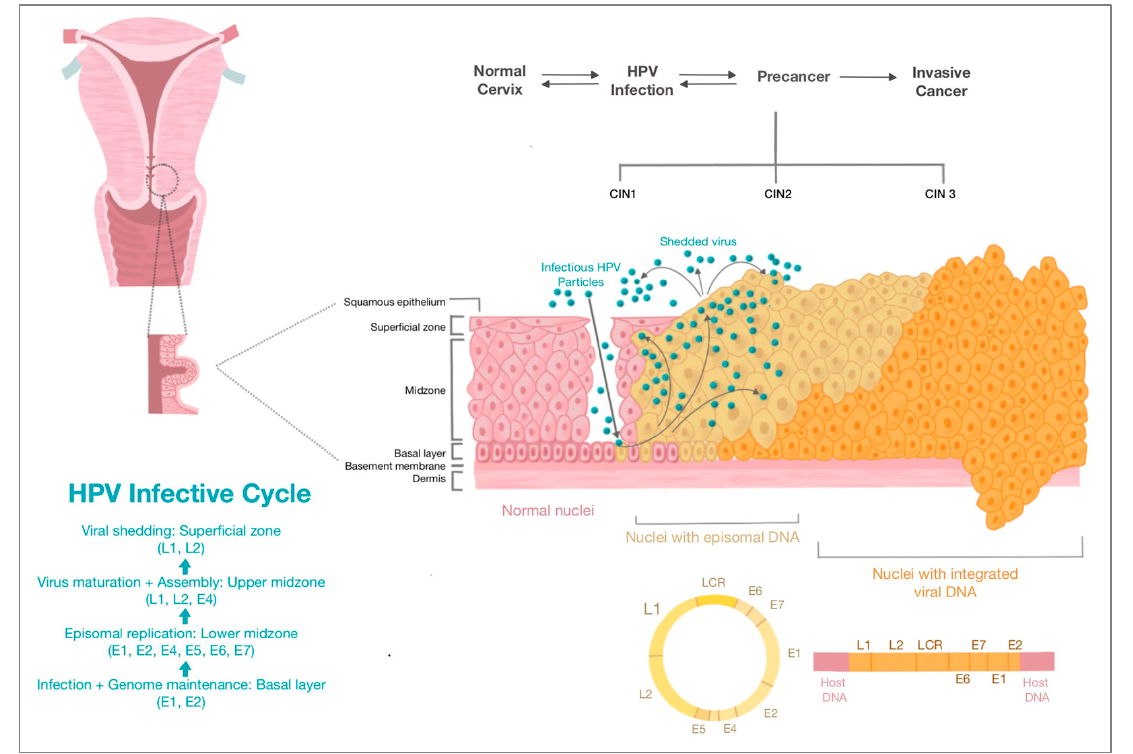
Figure 2. HPV infective cycle and cervical carcinogenesis (Source: authors).